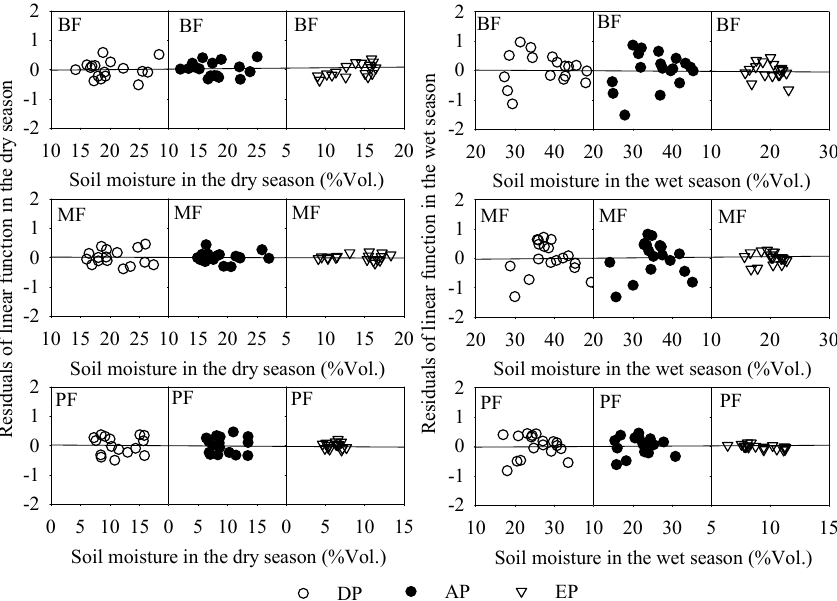
Fig. A4. Residual plots for the models of soil respiration rate ( R , µmolCO 2 m − 2 s − 1 ) and soil temperature at 5cm depth ( T , ◦ C) (linear regression equation: R = a + cM ) under different seasons and different precipitation treatments at the DNR forests. The treatments are as follows: precipitation exclusion (EP), ambient precipitation (AP), and double precipitation (DP). The forests are as follows: broadleaf forest (BF), mixed forest (MF), and pine forest (PF).